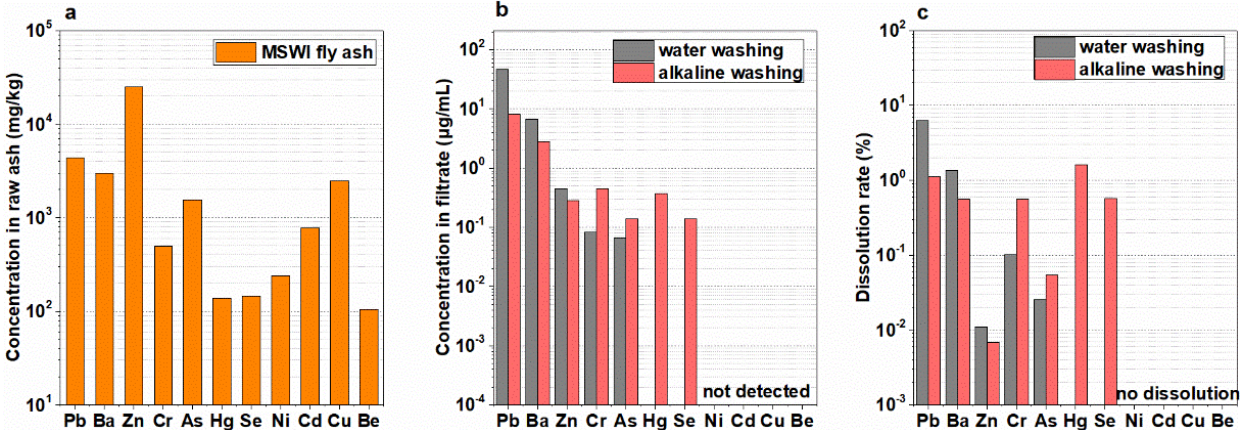
Figure 6. Heavy metals concentration in MSWI fly ash ( a ), filtrate ( b ) and their dissolution rate ( c ) after washing by water (L/S = 6 mL/g) and alkaline solution (L/S = 6 mL/g, 0.2 g NaOH/g ash).